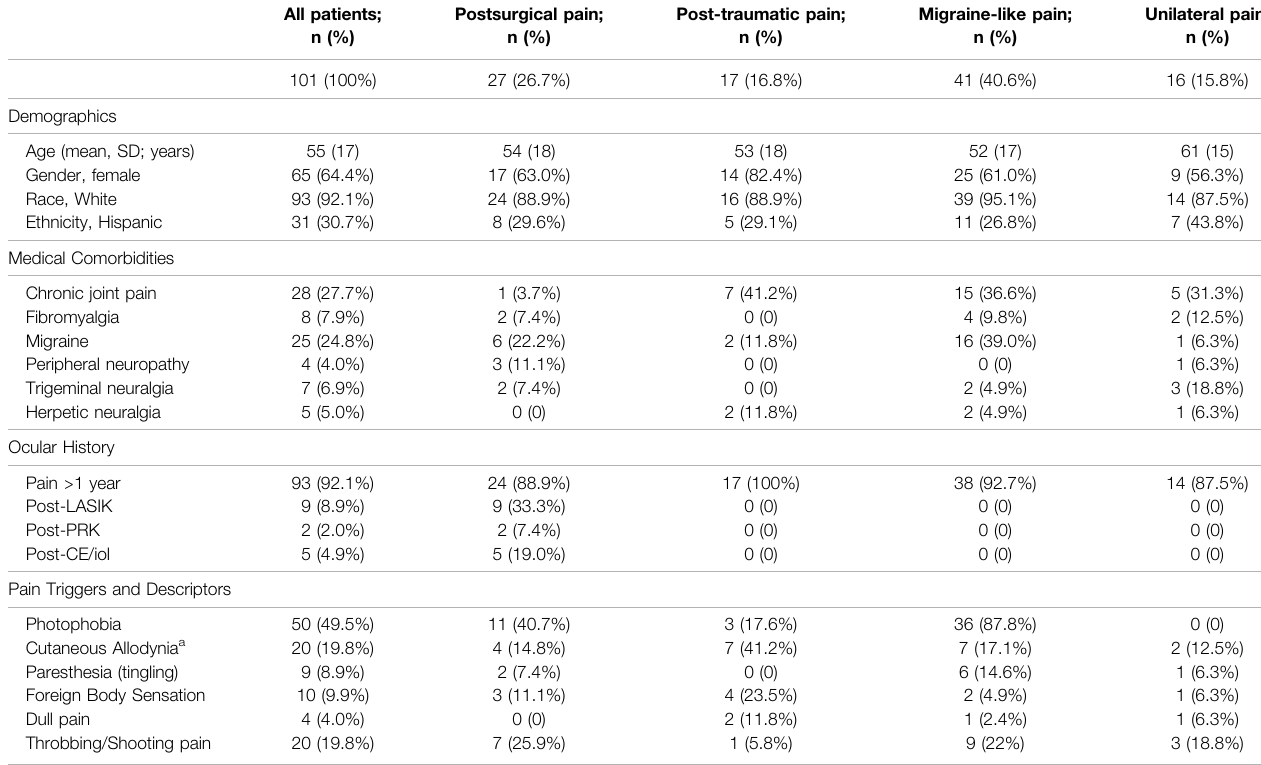
a Pain on light touch of the skin around the eye. SD (cid:1) standard deviation; LASIK (cid:1) laser-assisted in situ keratomileusis; PRK (cid:1) photorefractive keratectomy; CE/iol (cid:1) cataract extraction and intraocular lens.